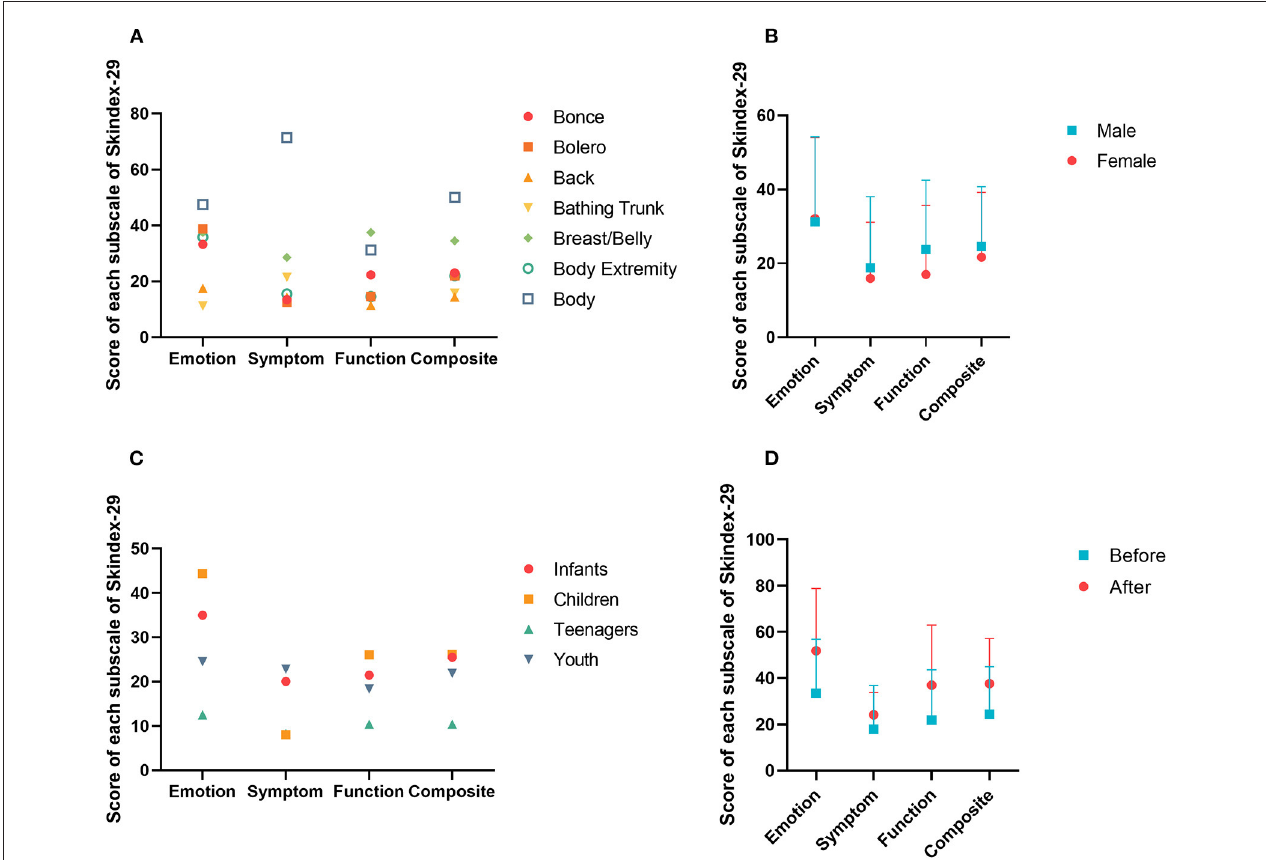
FIGURE 1 | Score of each subscale in Skindex-29. (A) Scores of different distribution patterns of LCMN based on “7B” rule in four subscales. (B) Scores of different genders in four subscales. (C) Scores of different generations in four subscales. (D) Scores of different periods in four subscales.